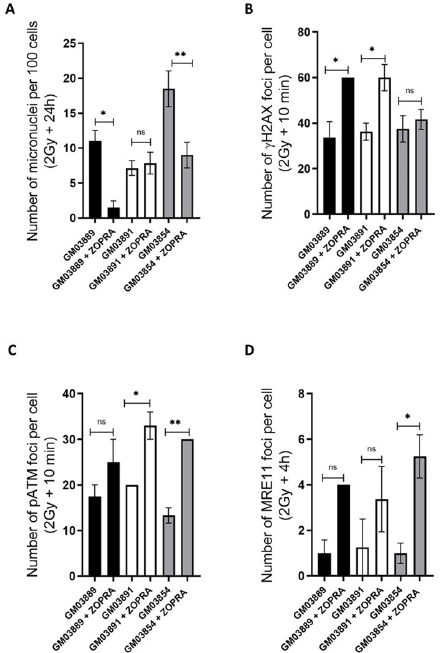
Figure 9. Effect of ZOPRA treatment in USH1 fibroblasts in response to radiation: Numbers of micronuclei per 100 cells assessed after 2 Gy followed by 24 h post-irradiation ( A ), numbers of γH2AX foci per cell assessed after 2 Gy followed by 10 min post-irradiation ( B ), numbers of pATM foci per cell assessed after 2 Gy followed by 10 min post-irradiation ( C ), and numbers of MRE11 foci per cell assessed after 2 Gy followed by 4 h post-irradiation ( D ) in the GM03889, GM03891, and GM03854 USH1 fibroblasts, with or without ZOPRA treatment. Data points represent the mean ± SEM of duplicate experiments. Asterisks represent the statistically significant differences from radioresistant controls, expressed as p -values (1, and 2 asterisks correspond to p < 0.05, and p < 0.01, respectively, ns corresponds to p >